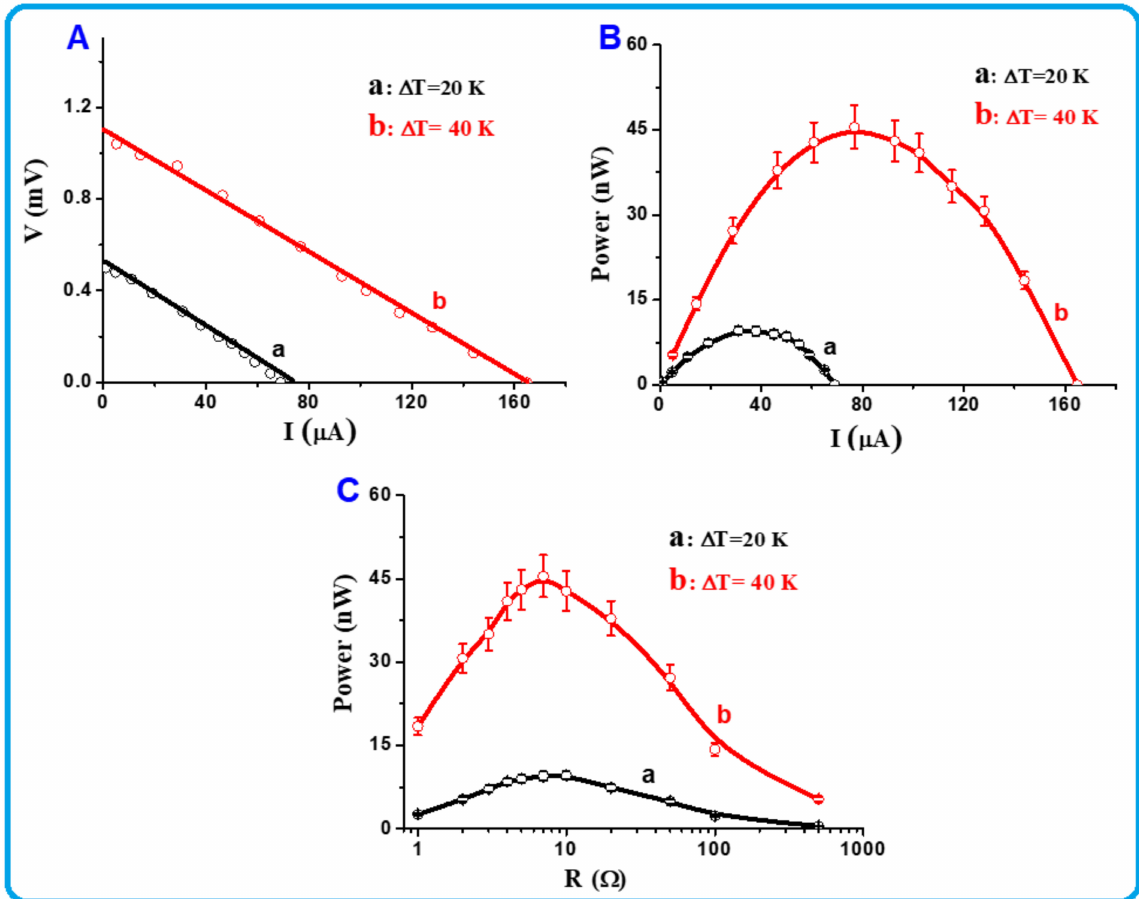
Figure 8. ( A – C ) Above/near RT thermoelectric power characteristics of TOS single leg module at ∆ T = 20 K and 40 K (for ∆ T = 20 K; T 1 = 283 K and T 2 = 303 K, for ∆ T = 40 K; T 1 = 293 K and T 2 = 333